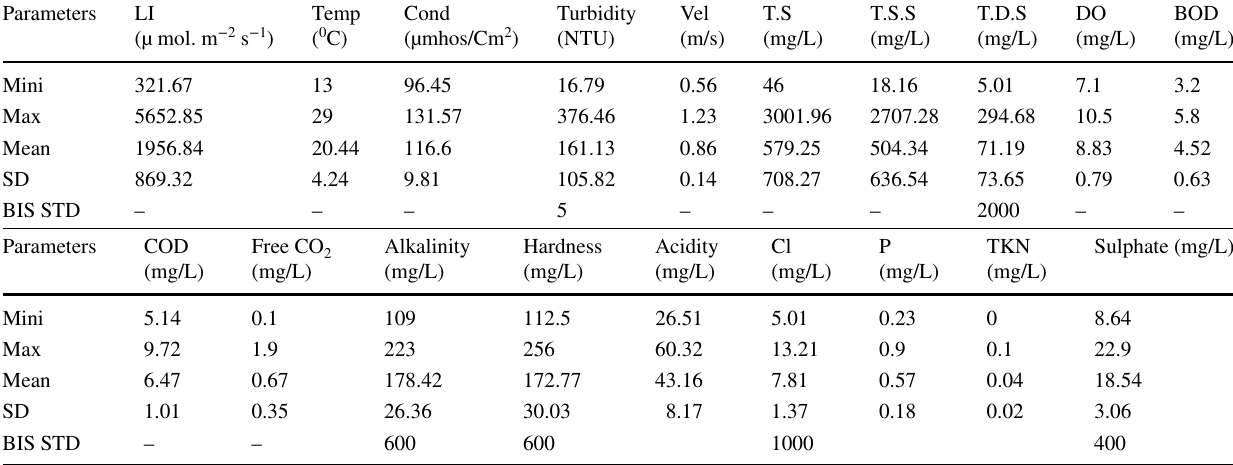
Table 3 Descriptive statistics for study area along with standard limits proposed by BIS (2012)